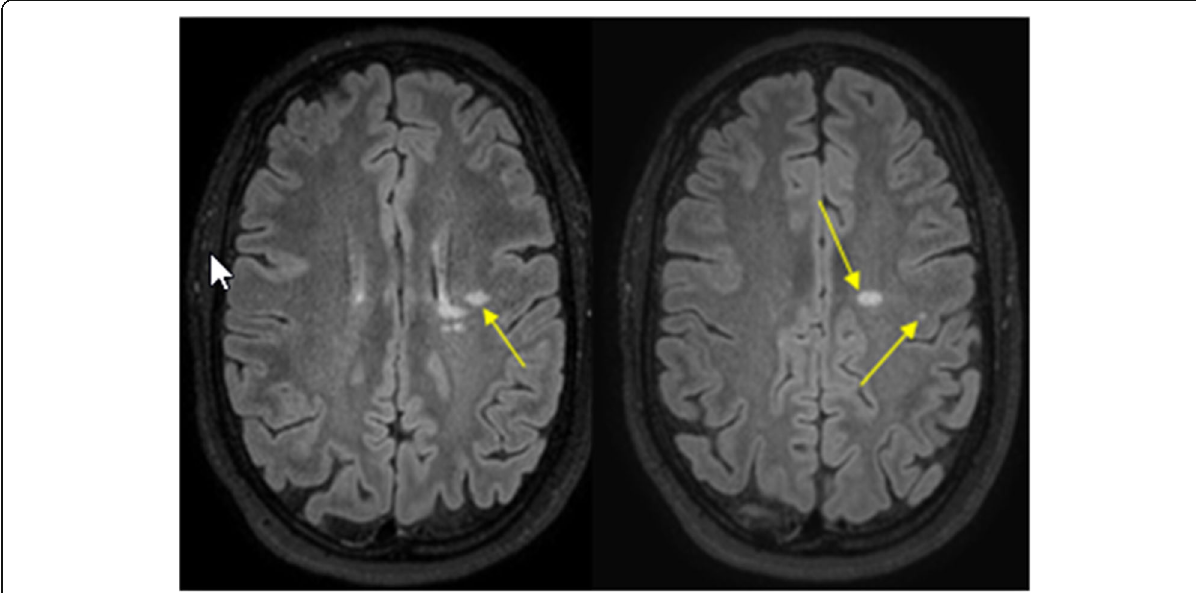
Fig. 5 Axial 3D FLAIR sections showing subcortical white matter lesions separated from the cortex by white